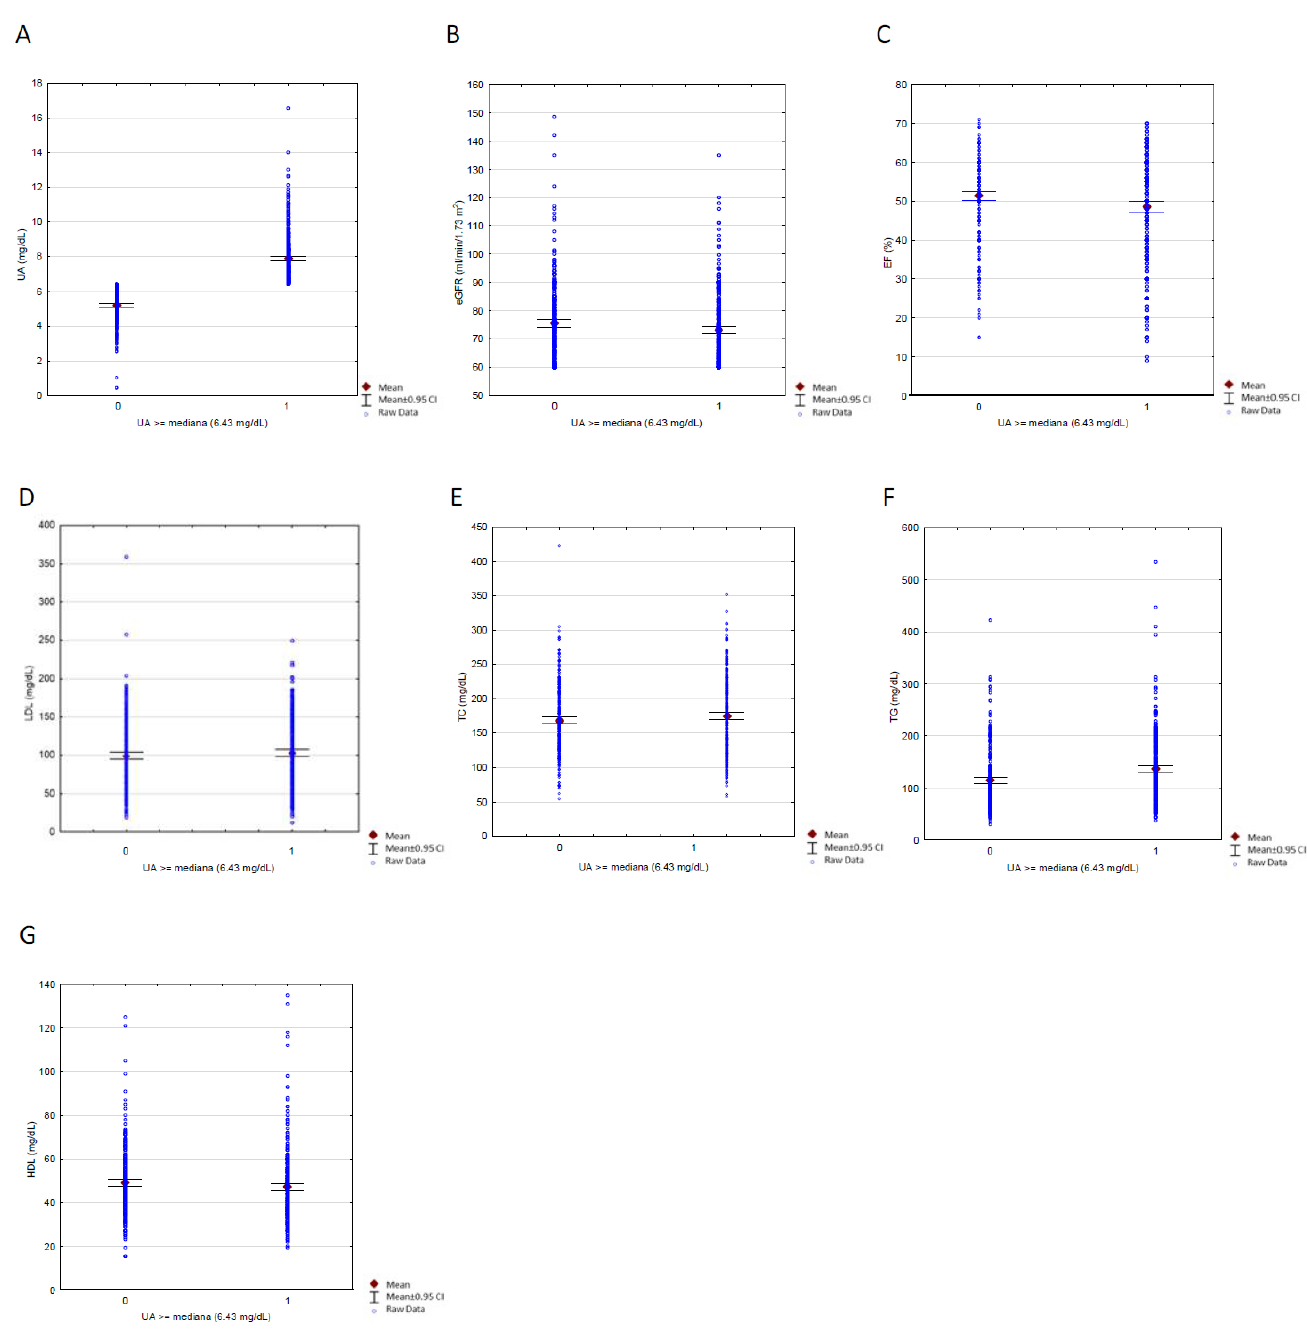
Figure 4. Scatterplots with error bars for comparison of groups, based on median UA concentration (6.43 mg/dL), as far as fallowing variables are concerned: ( A ) eGFR, ( B ) UA concentration, ( C ) EF, ( D ) LDL concentration, ( E ) TC concentration, ( F ) TG concentration, ( G ) HDL concentration. Abbreviations: UA, uric acid; EF, ejection fraction; eGFR, estimated glomerular filtration rate; TC, total cholesterol; LDL, low-density lipoproteins; TG, triglycerides; HDL, high-density lipoproteins; CI, confidence interval .